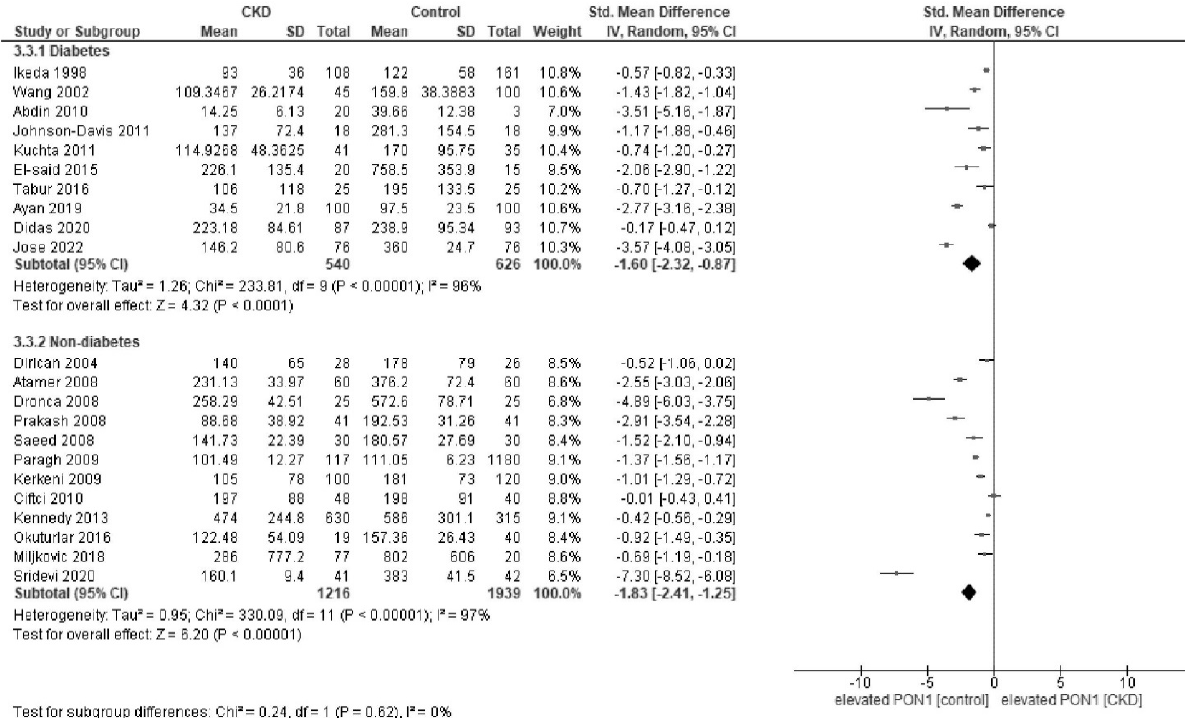
Figure A2. Forest plot of paraoxonase activity stratified by diabetes status [26–42,44,46–49].